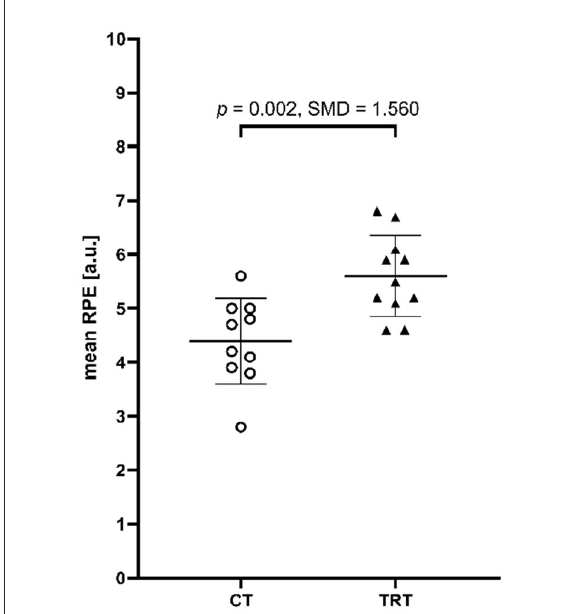
FIGURE3 Mean perceived effort of each session for all participants of the cluster training group (CT, circles) and traditional training group (TRT, triangles). Further, mean values and standard deviations, p -values of the independent t -test, and standardized mean differences (SMD) are indicated